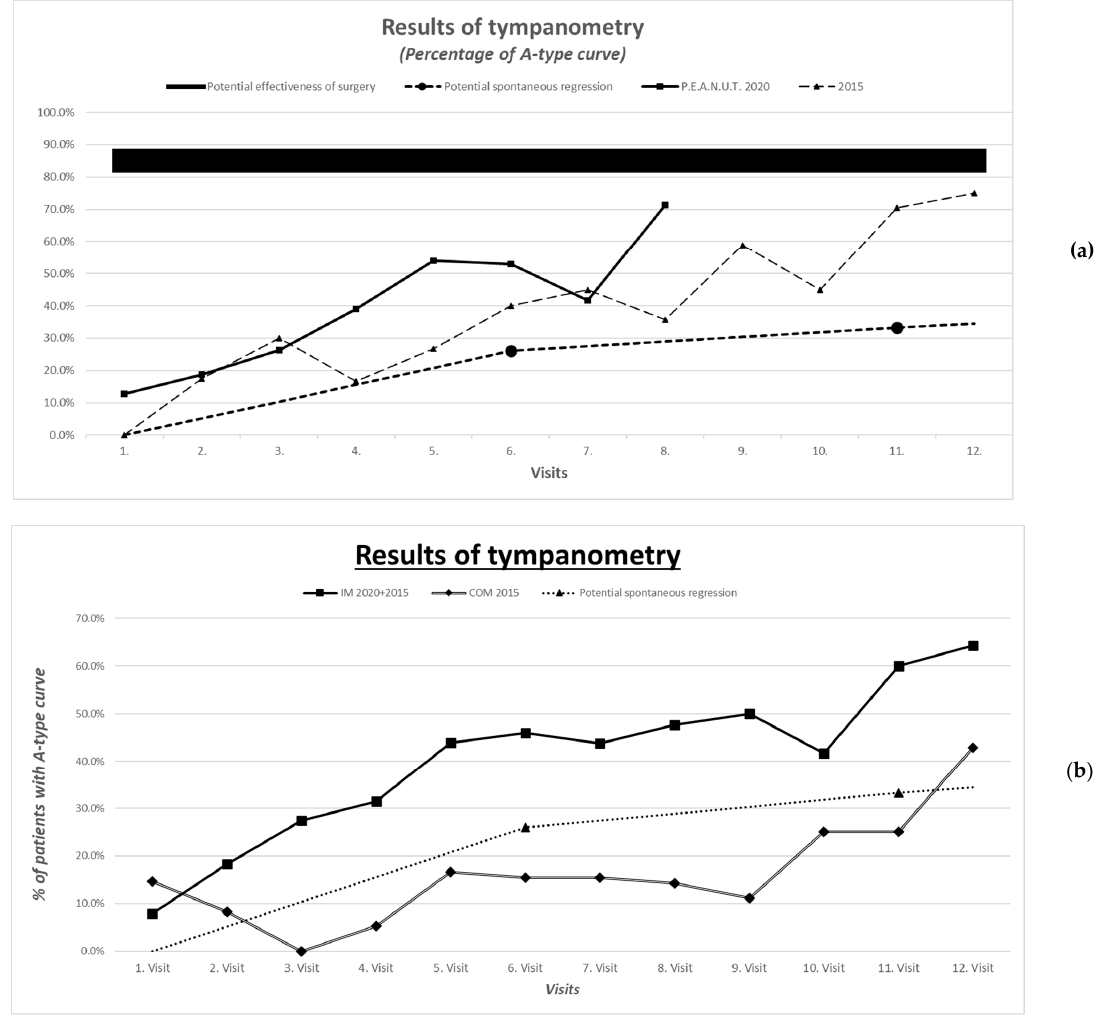
Figure 1. ( a ) Improvement in tympanometric measurement IM (2015 vs. 2020). ( b ) Improvement in tympanometric measurement (COM 2015 vs. IM 2015 + 2020).